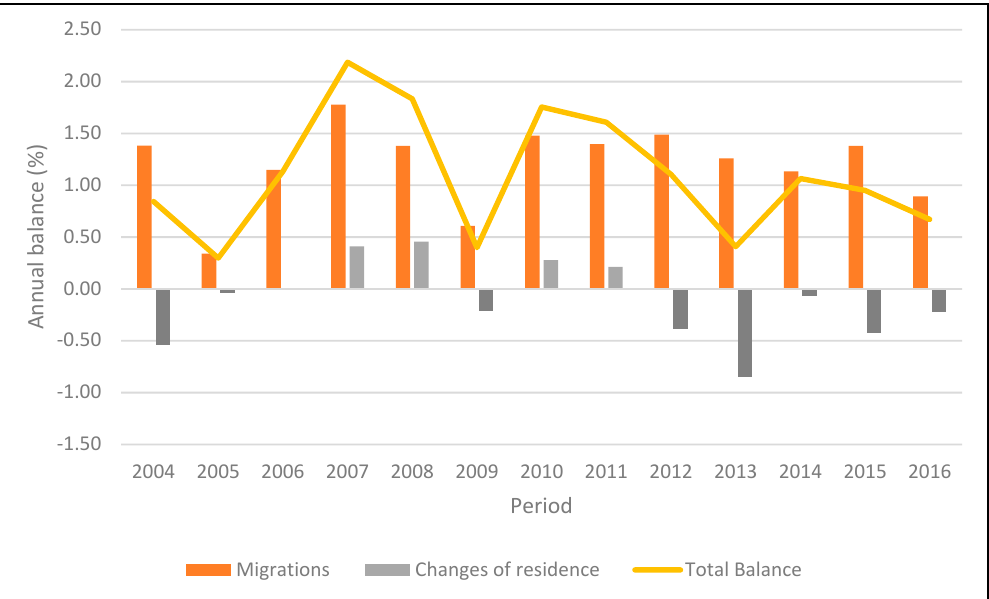
Figure 3. Migration balance in the Cabanyal neighborhood, 2004–2016.